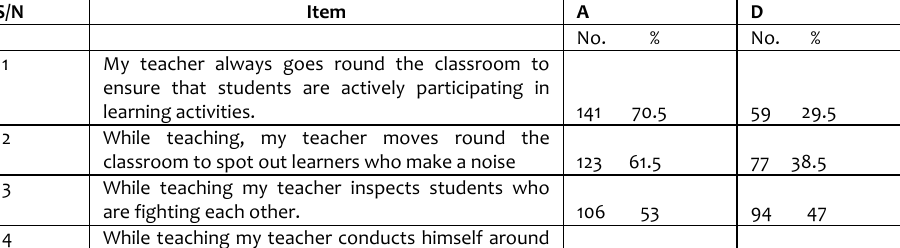
Figure 3: Percentage Presentation of data for question